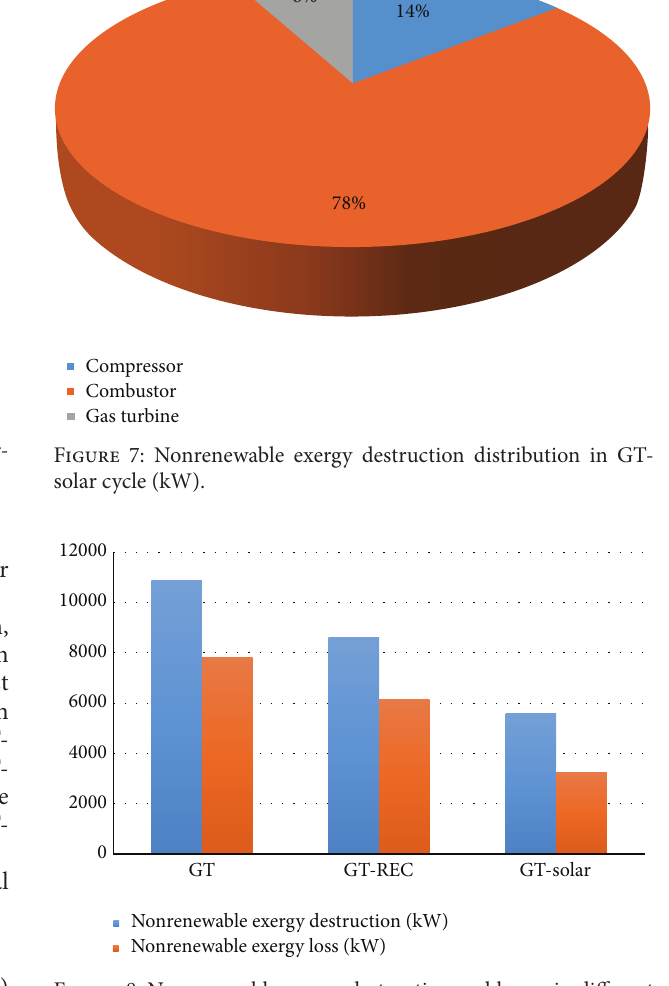
Figure 8: Nonrenewable exergy destruction and losses in different